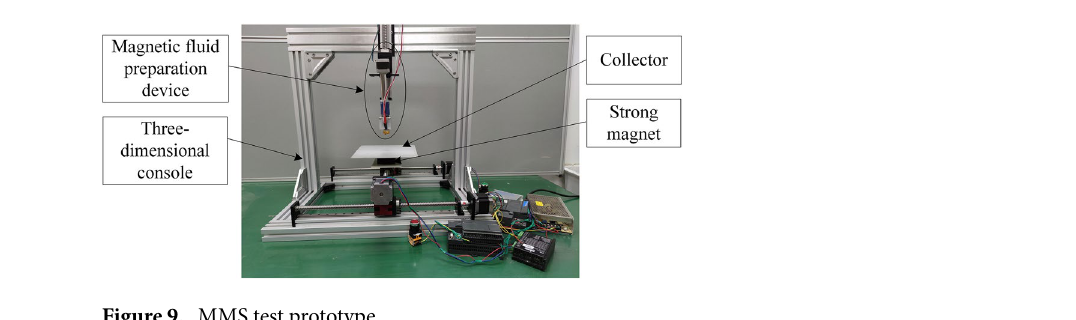
Figure 9. MMS test